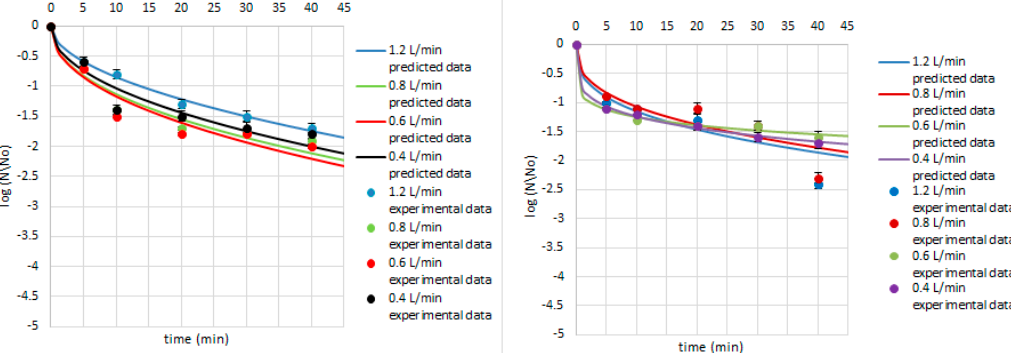
Figure 5. Survival of B. subtilis on the cardamom seed ( left ) and juniper berry ( right ) matrix treated with ozone doses stimulated with flow rate of 1.2, 0.8, 0.6, and 0.4 L/min after 5, 10, 20, 30, and 40 min. Solid line: prediction of the Weibull model (egns 6–7), dotted line: bacterial log counts.